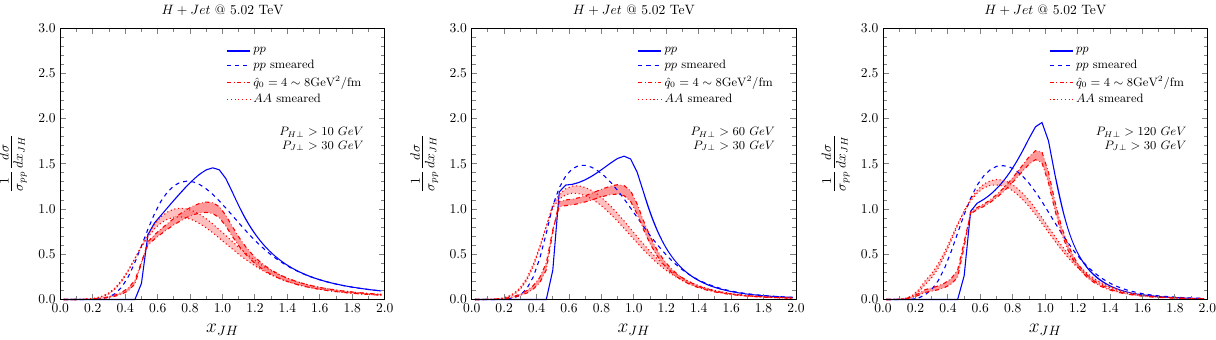
Fig. 10 A projection of the normalized x JH distribution both smeared and unfolded for pp and PbPb collisions in the same kinematic settings as in the Z + jet CMS [60] experiment. Panels from left to right are P H ⊥ > 0, 60 and 120 GeV respectively. AA results are normalized to the pp